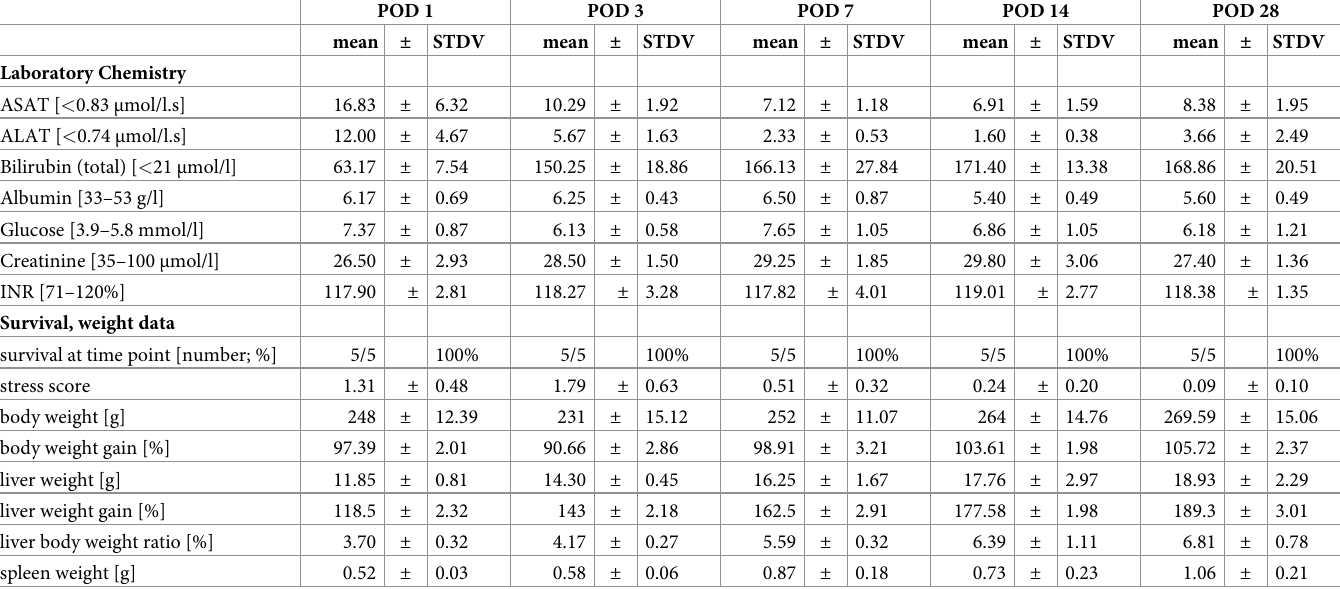
Table 2. Results of laboratory chemistry and data of survival and weight data after tBDT in rats.